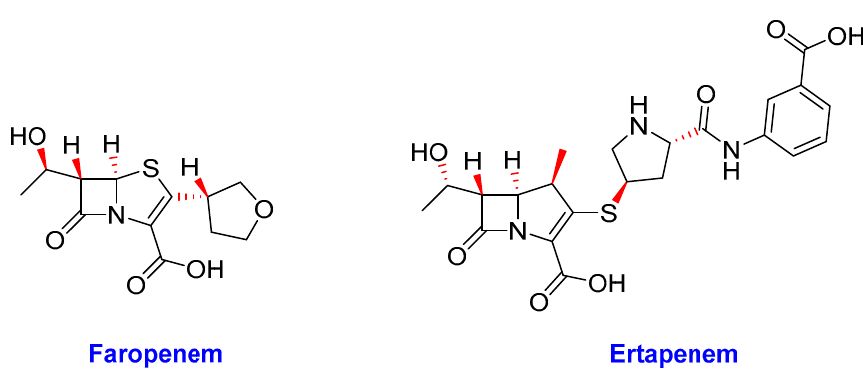
Figure 12. The chemical structures of faropenem and ertapenem.